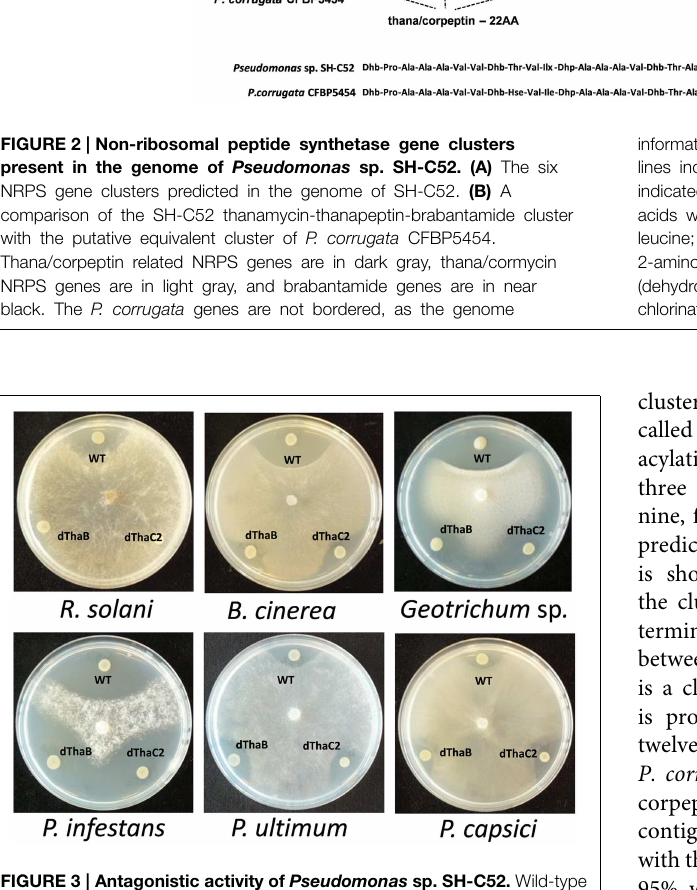
FIGURE 3 | Antagonistic activity of Pseudomonas sp. SH-C52. Wild-type (WT) and the thanamycin mutant strains (ThaB, ThaC2) were tested in dual culture assays for activity against fungal plant pathogens (upper panel) and oomycete plant pathogens (lower panel)